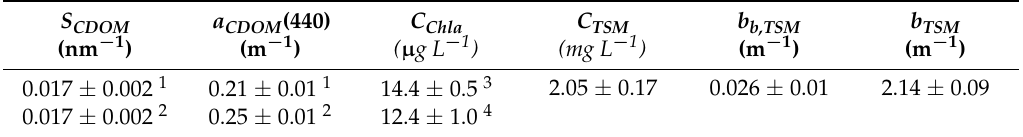
Table 1. Results from water sample and in-situ probe data